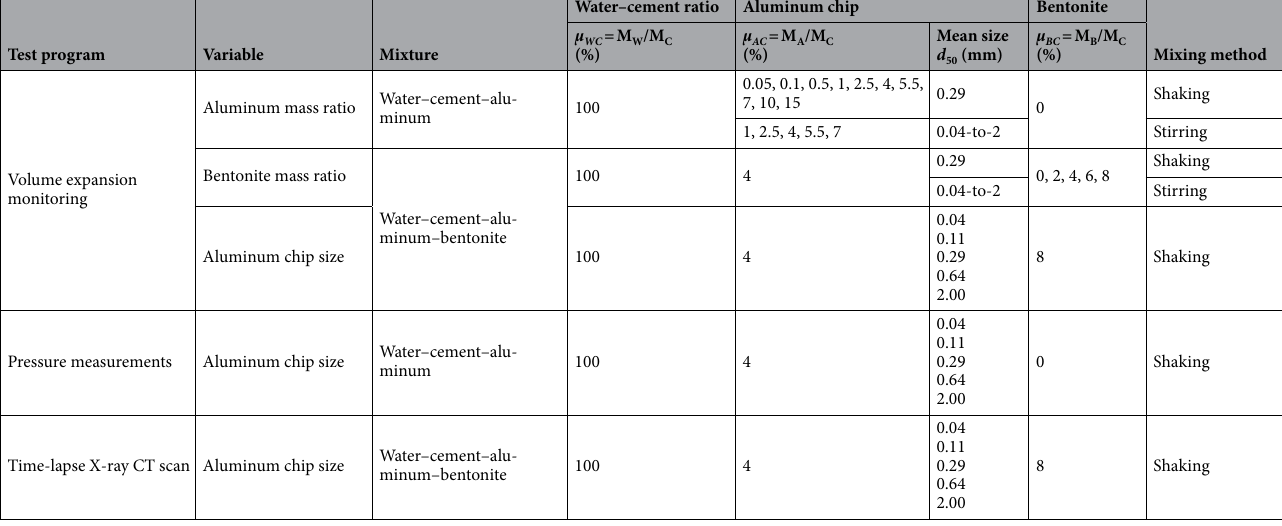
Table 1. Sample preparation—mass-based mixing ratios for cement paste